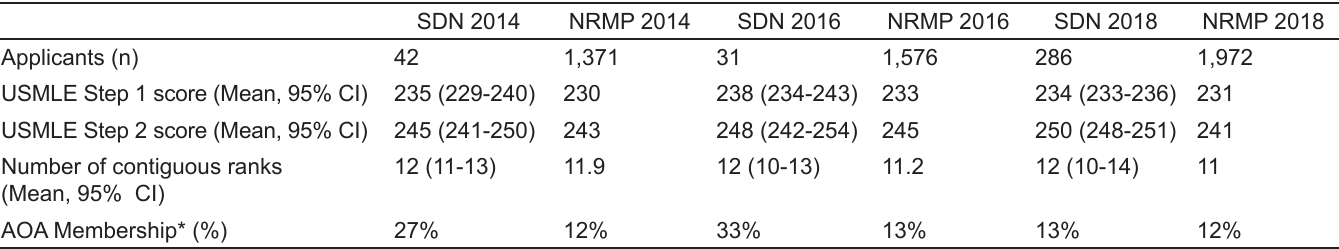
Table 2. Comparison of Student Doctor Network and National Resident Matching Program data.